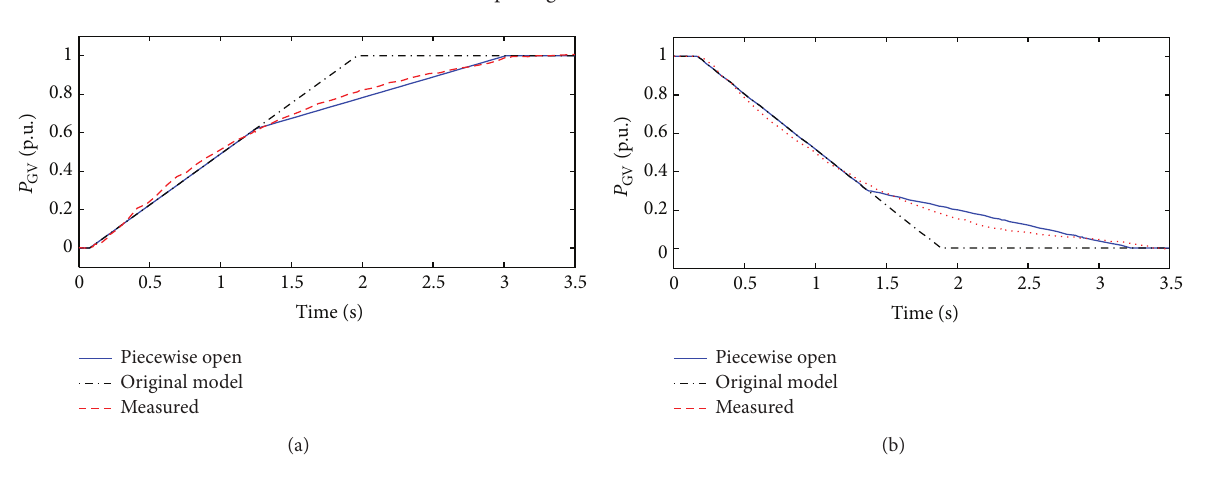
Figure 11: Valve fully open and close simulation